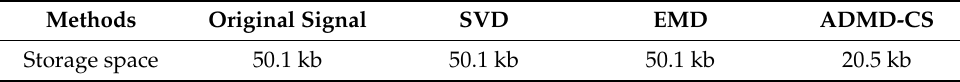
Table 7. Storage space for the experimental signal by different